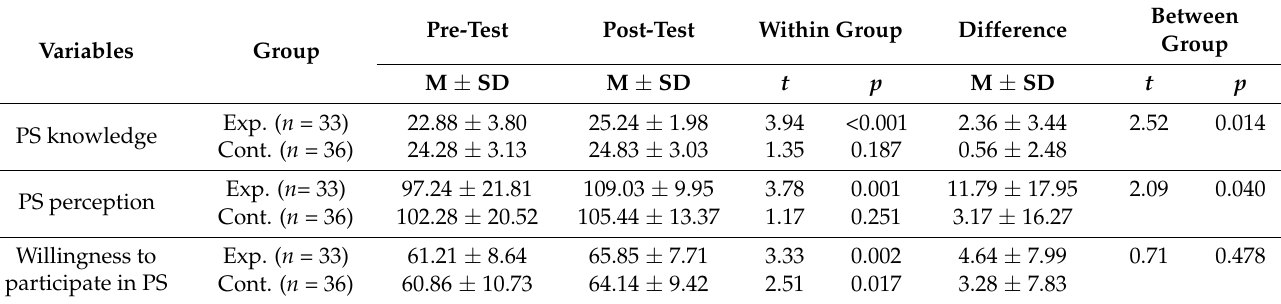
Table 4. Differences of variables between the experimental and control group ( N =